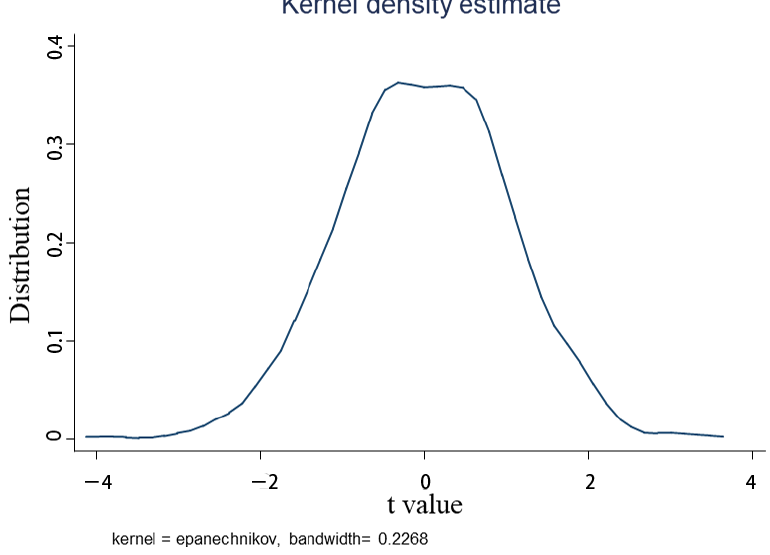
Figure 2. Core density distribution diagram.